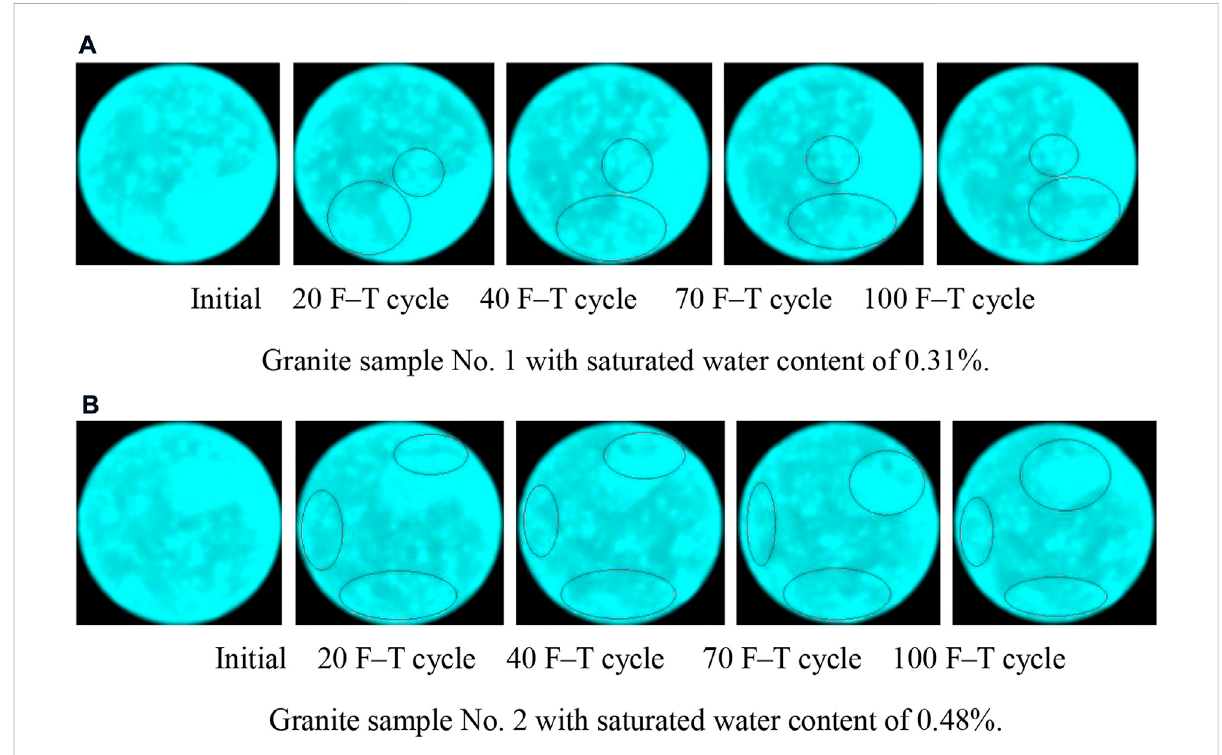
FIGURE 12 CTimagesoftheninthscanninglayerforgranitesamplesunderdifferentnumbersofF – Tcycles.Initial20 F – Tcycle40 F – Tcycle70 F – Tcycle 100 F – T cycle. (A) Granite sample No. 1 with saturated water content of 0.31%. Initial 20 F – T cycle 40 F – T cycle 70 F – T cycle 100 F – T cycle. (B) Granite sample No. 2 with saturated water content of